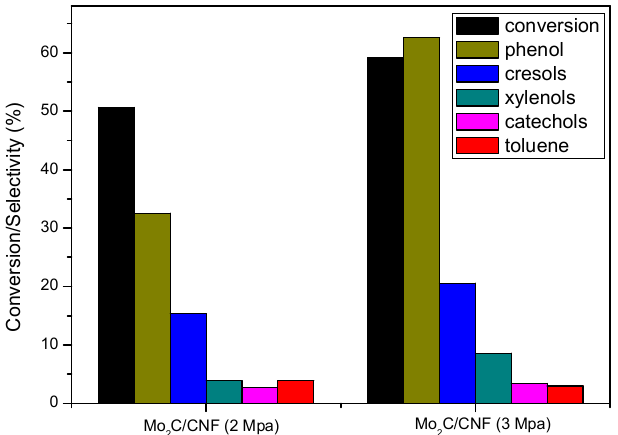
Figure 6. Conversion and product selectivities of the main reaction products during the hydrodeoxygenation of guaiacol over the Mo 2 C/CNF catalyst at 623 K, 2 h reaction time and 2 and 3 Mpa H 2 pressure.